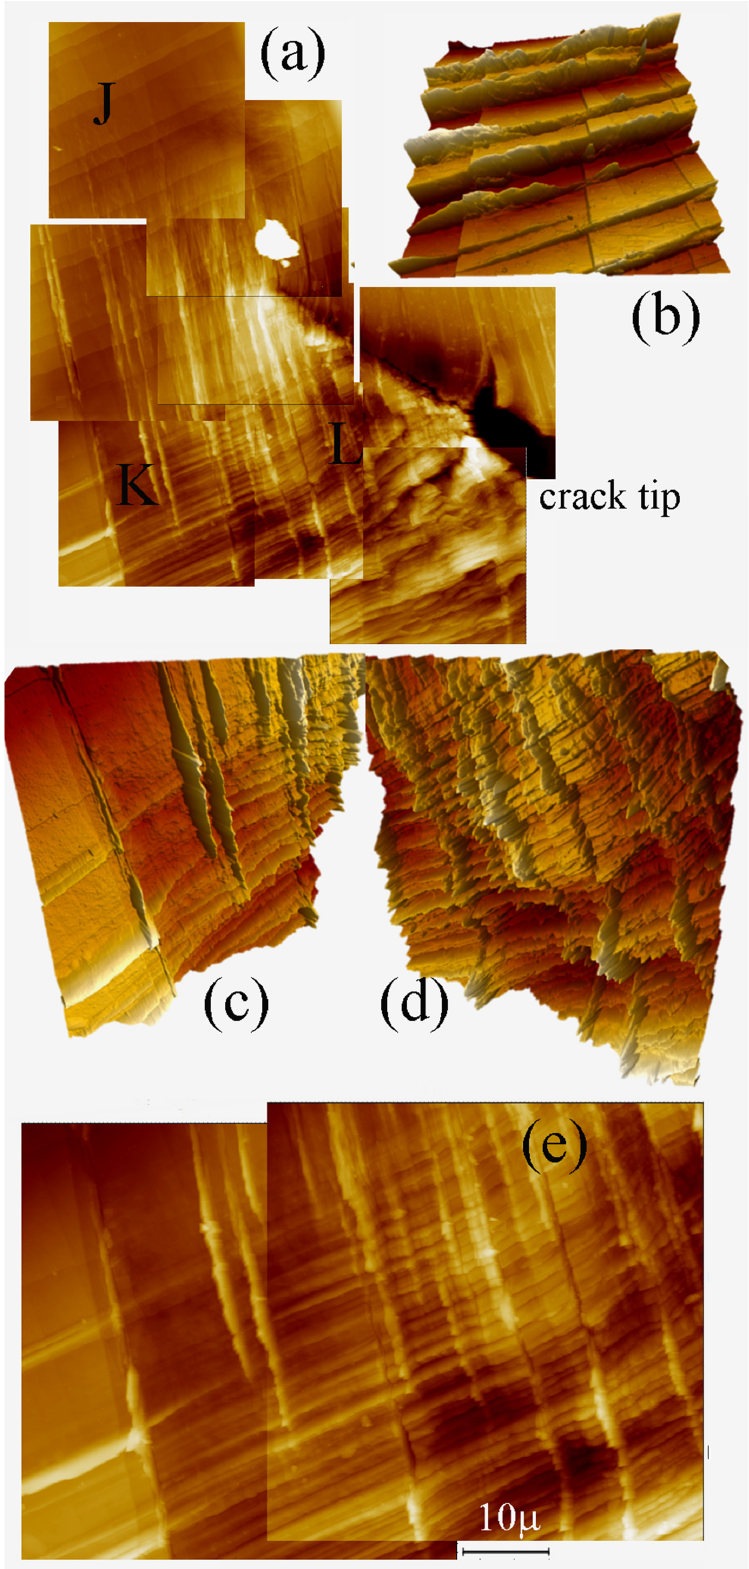
Figure 8. AFM images of the free surface of specimen 2. ( a ) General view of the crack tip; ( b ) typical slip steps and extrusions in area J; ( d ) Intensive slip in area L; ( c , e ) two views of area K illustrate the fading of the slip lines with increasing distance from the